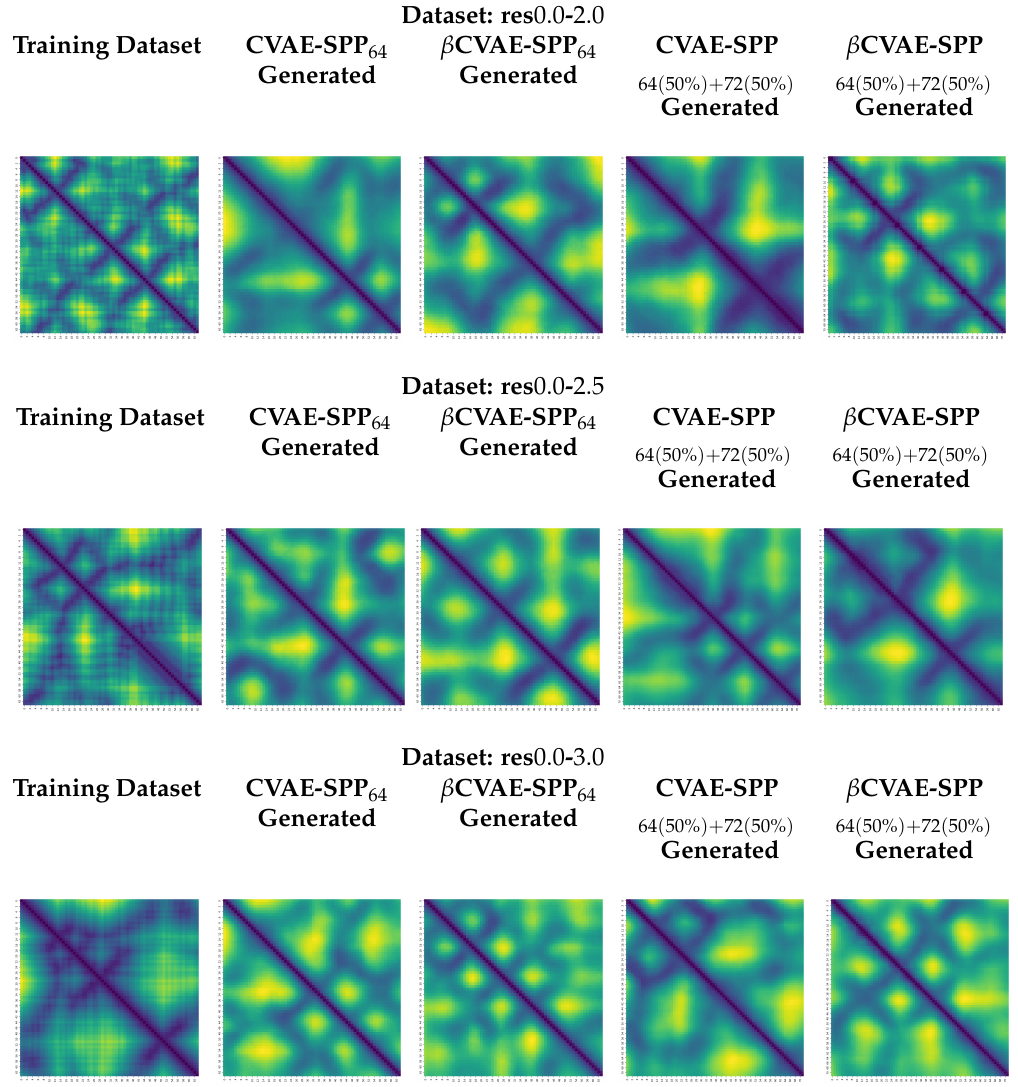
Figure 9. We relate here distance matrices selected at random over a training dataset (leftmost column) and over generated datasets (other columns) for each model and two of the training dataset configurations. The rows separate the three input datasets utilized. A yellow-to-blue color spectrum indicates high-to-low distance